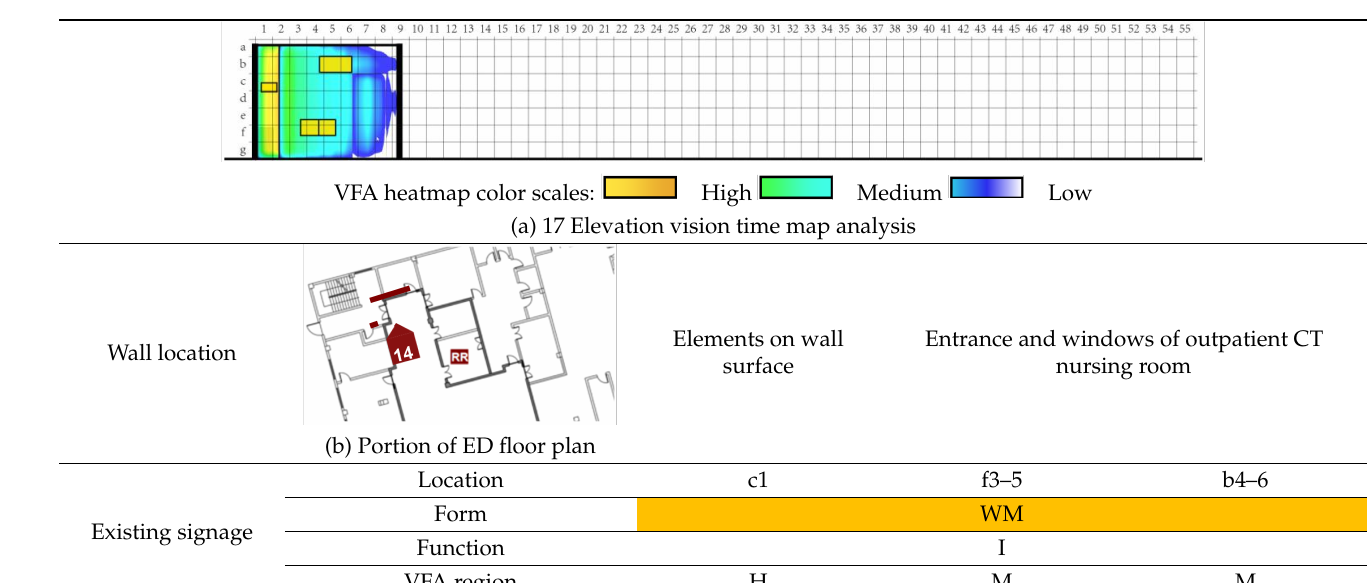
Table 21. 17 Elevation comparative